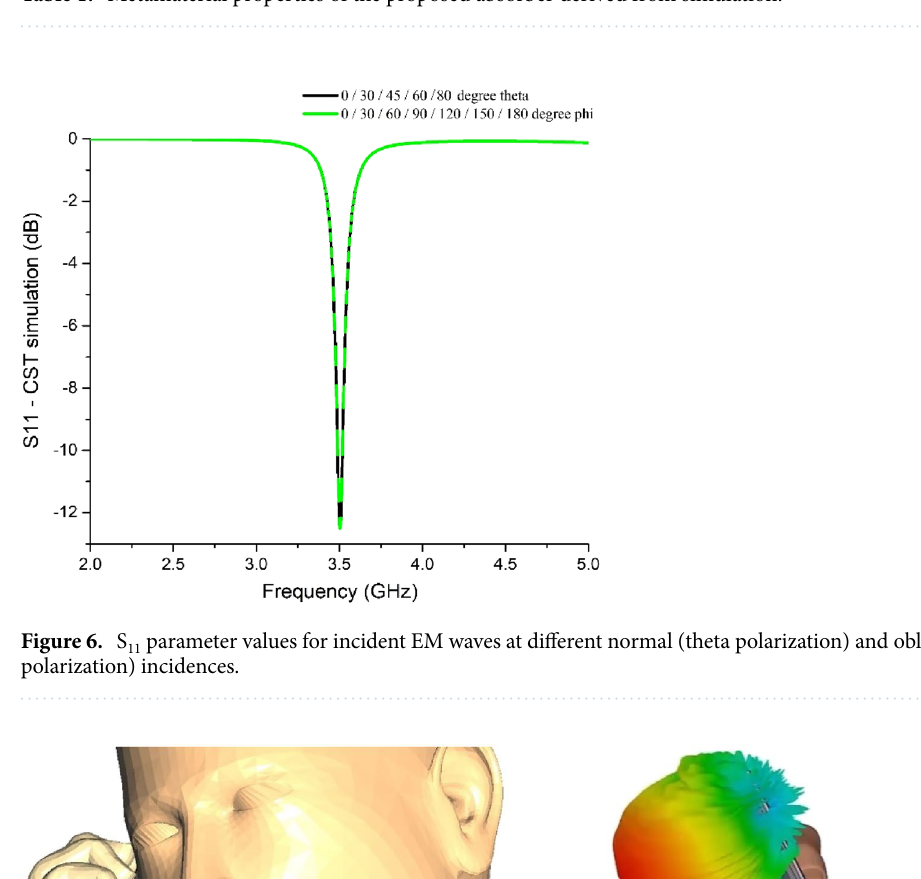
Table 1. Metamaterial properties of the proposed absorber derived from simulation.